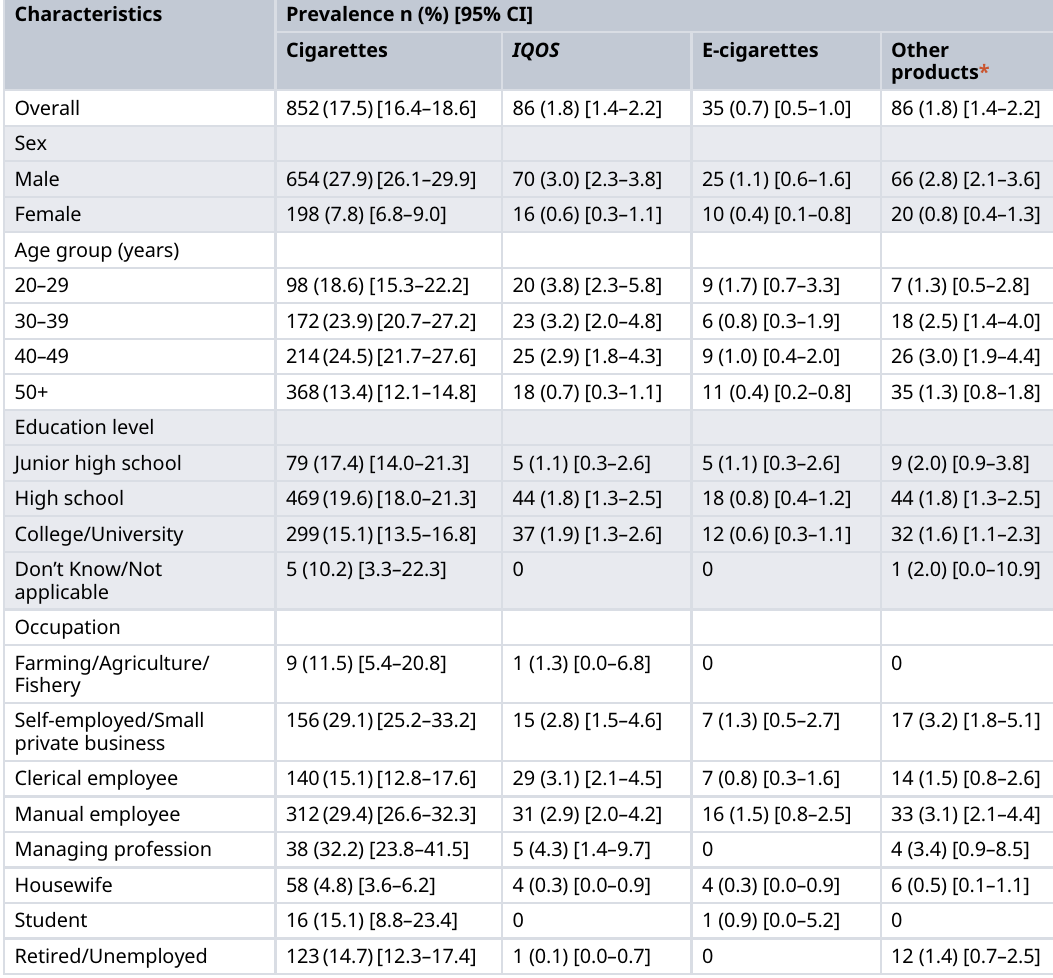
Table 2. Prevalence of TNP use in the general population survey (overall and stratified by sample characteristics).